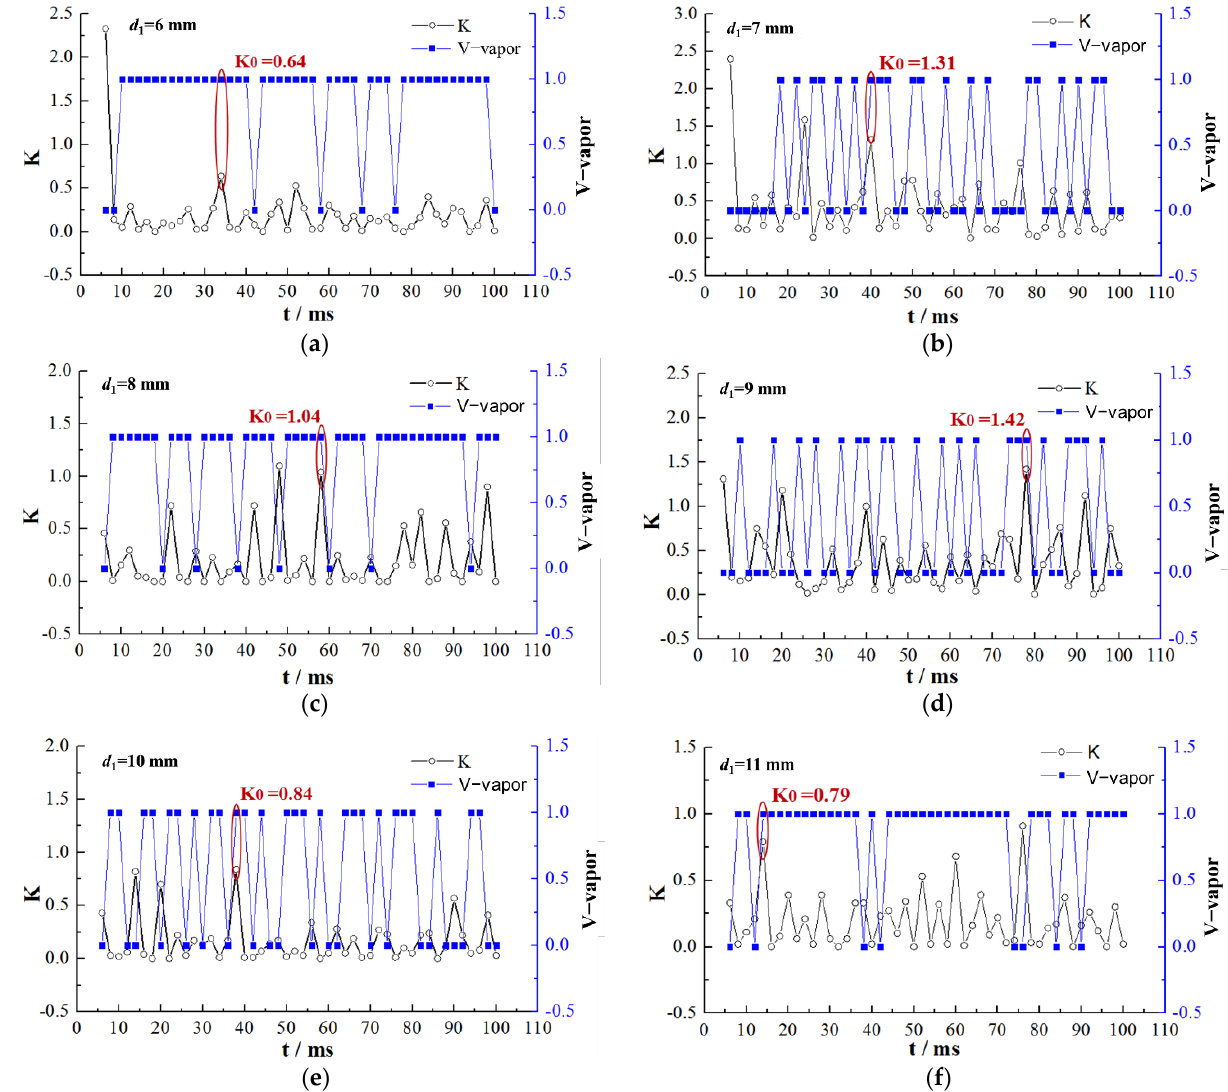
Figure 12. Cavitation number vs time for nozzles of various inlet diameters. ( a ) d 1 = 6 mm ( b ) d 1 = 7 mm ( c ) d = 8 mm ( d ) d 1 = 9 mm ( e ) d 1 = 10 mm and ( f ) d 1 = 11 mm.